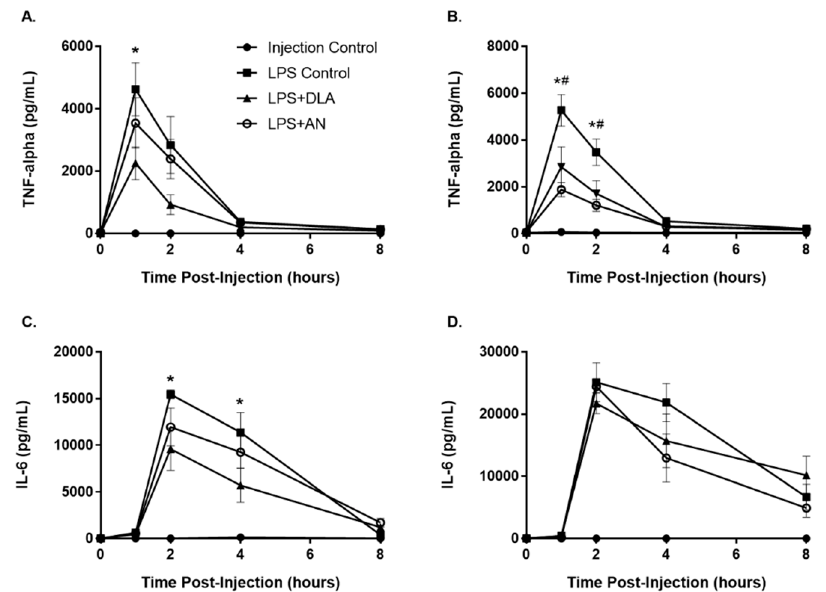
Figure 6. Production of proinflammatory cytokines TNF- α and IL-6 in male ( A , C ) and female ( B , D ) rats after LPS challenge and treatment with either pure artemisinin (AN) or DLA (equal artemisinin doses). n = 5–6 for experimental conditions, n = 3 for injection control; error bars = SEM; *, p ≤ 0.05 when comparing LPS+DLA to LPS Control; #, p ≤ 0.05 when comparing LPS+AN to LPS Control.